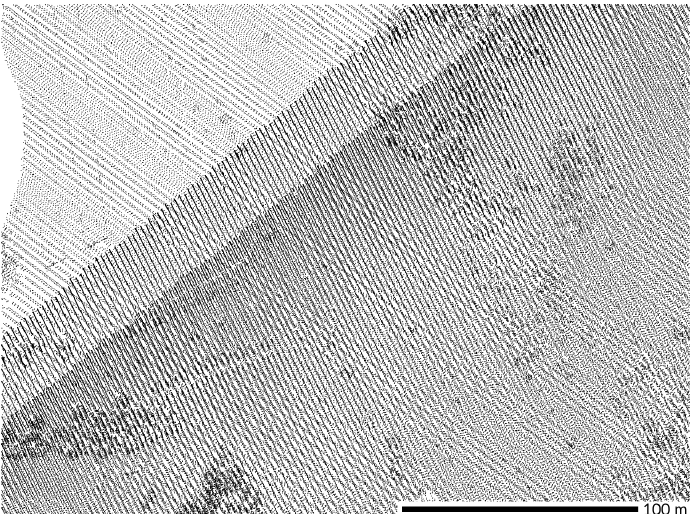
Figure 6. Example of a complex point distribution. The area is completely covered by one swath and partially covered by another. The border of the second one reveals the doubled scan pattern and higher density at the end of the scan line. There are bands of higher and lower densities in the direction of the flight (approximately diagonal direction). Other density variations are related to vegetation and the small area with missing points on the left is caused by a water body. Dataset: Wake County 2013 [43].